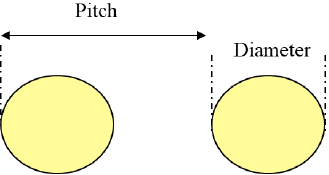
Figure 2: The holes' diameters and pitches of the sheets. The purpose of the design is to control the ratio of the superhydrophobic to the hydrophilic area in the samples.